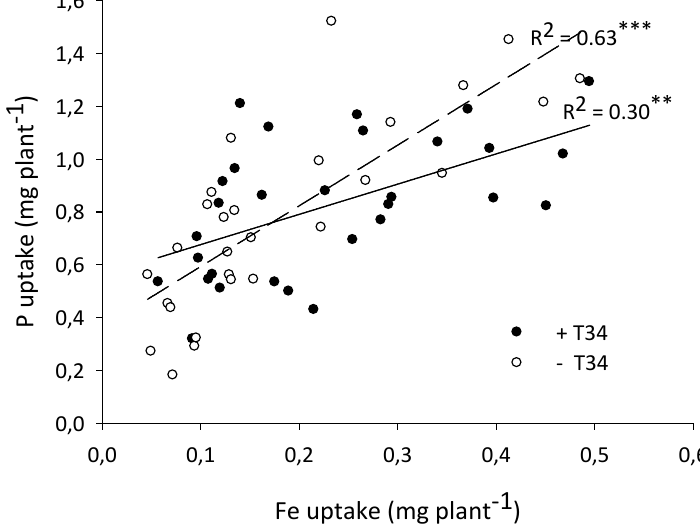
Fig. 1. Relationships between total P uptake and total Fe uptake by cucumber plants. The dotted line represents the linear regression for plants without T34 inoculation (Y = 0.36 + 2.3 X) and the solid line that for inoculated plants (Y = 0.56 + 1.15 X). The intercept and slope of both regression lines were significantly different at p < 0.05